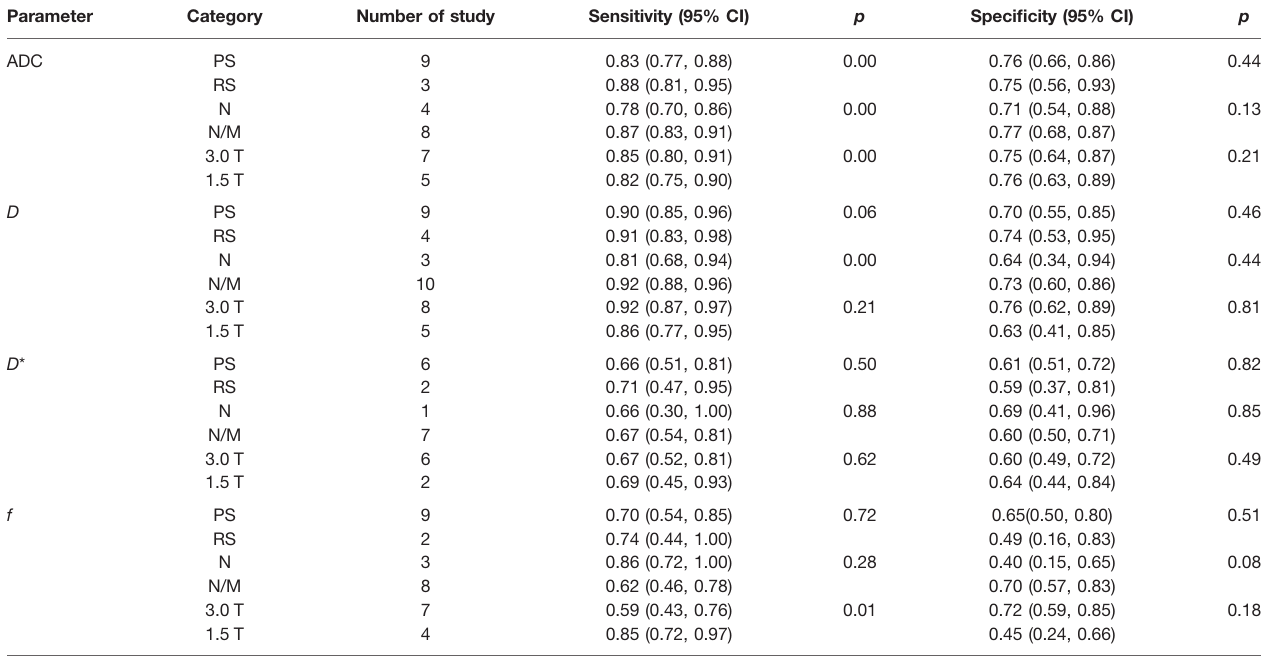
TABLE 3 | Results of multiple univariate meta-regression and subgroup analysis.